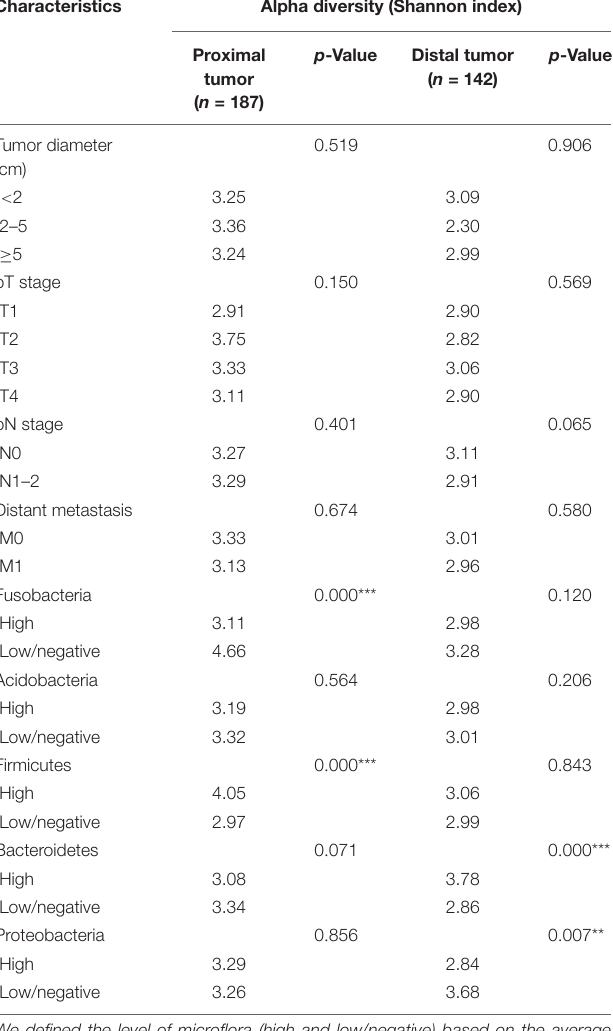
TABLE 2 | Associations of alpha diversity in proximal and distal CRC tumor tissues with tumor characteristics.